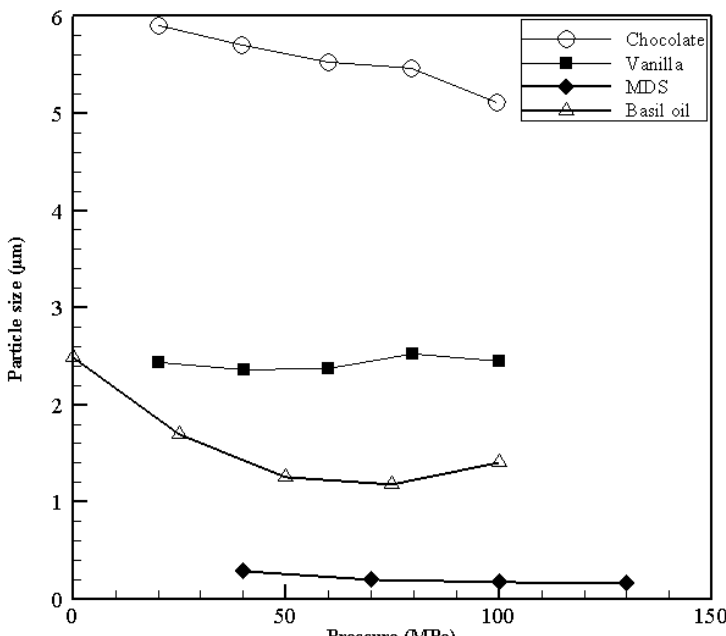
Figure 1: Mean particle size of chocolate- and vanilla-based products subjected to high-pressure homogenization (20– 100 MPa), MDS value subjected to 40-130 MPa HPH and basil oil subjected to 0-100 MPa HPH [5, 12,